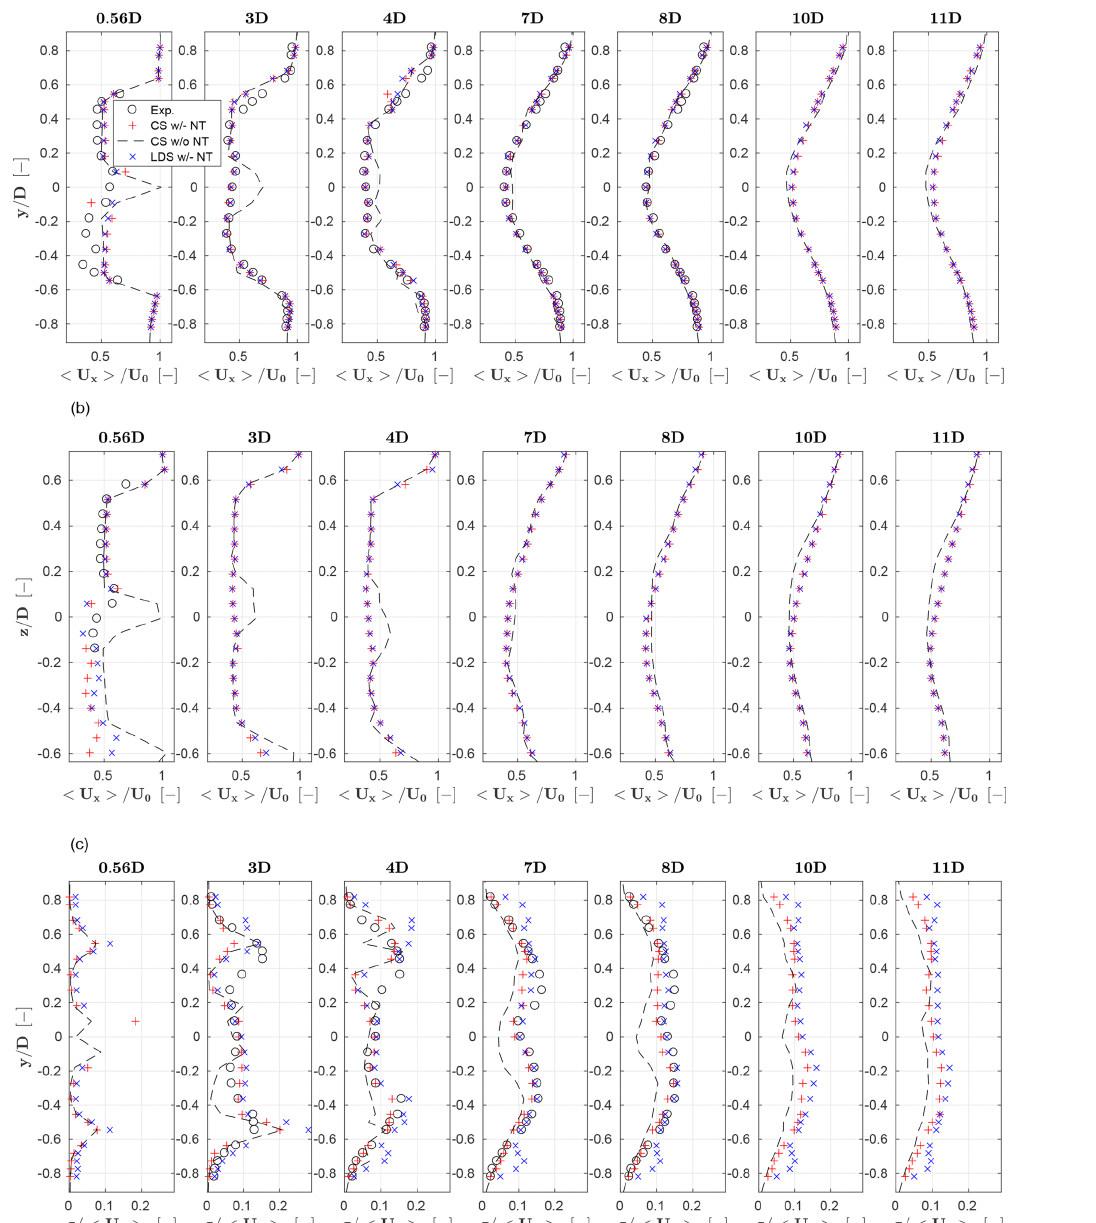
Figure 5. Profiles of normalized time-averaged streamwise velocity (cid:104) u x (cid:105) /U 0 along hub-height horizontal lines (a) and along vertical lines through the hub (b) . Turbulence intensity σ/ (cid:104) u x (cid:105) along hub-height horizontal lines (c) . Red + symbols: CS model with nacelle and tower; black dashed line: CS model without nacelle and tower; blue × symbols: LDS model with nacelle and tower; black ◦ symbols: experimental